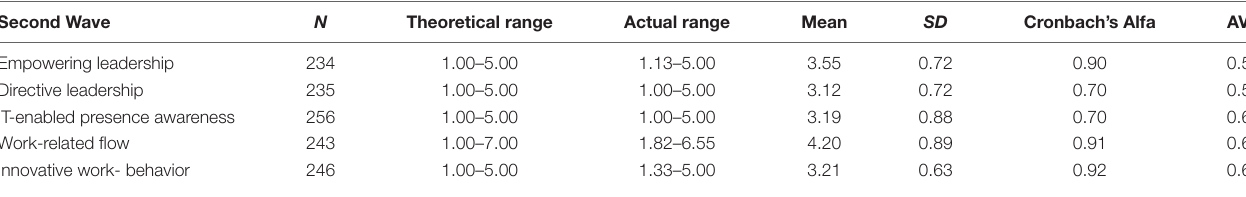
TABLE 3 | Construct descriptive statistics Second